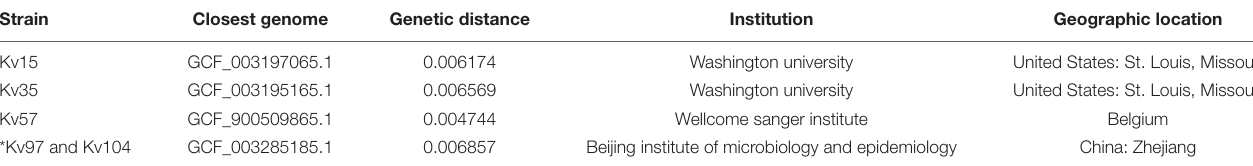
TABLE 3 | The closest genome to each of Klebsiella variicola strains isolated in Brasilia, DF, Brazil, based on the absolute values of genome distances. Strain Closest genome Genetic